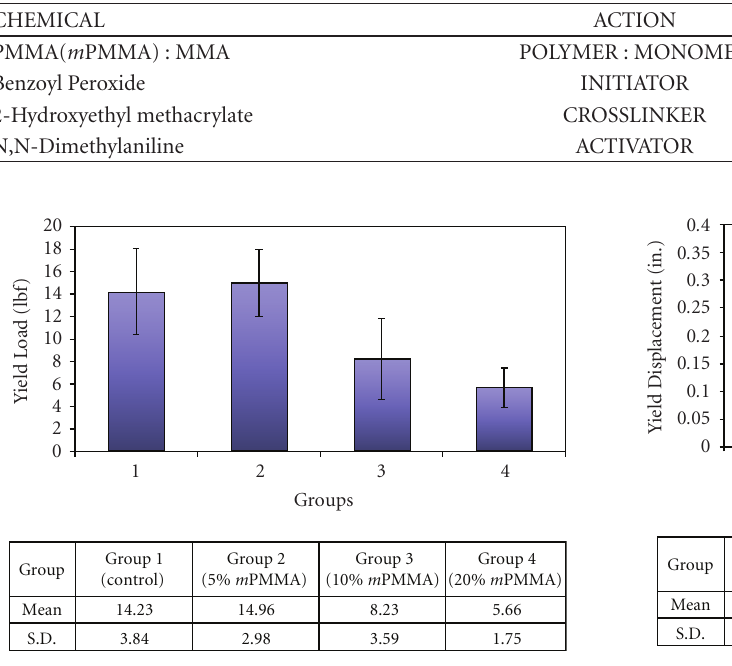
Figure 2: The mean and standard deviation values for transverse deflection for each of the experimental